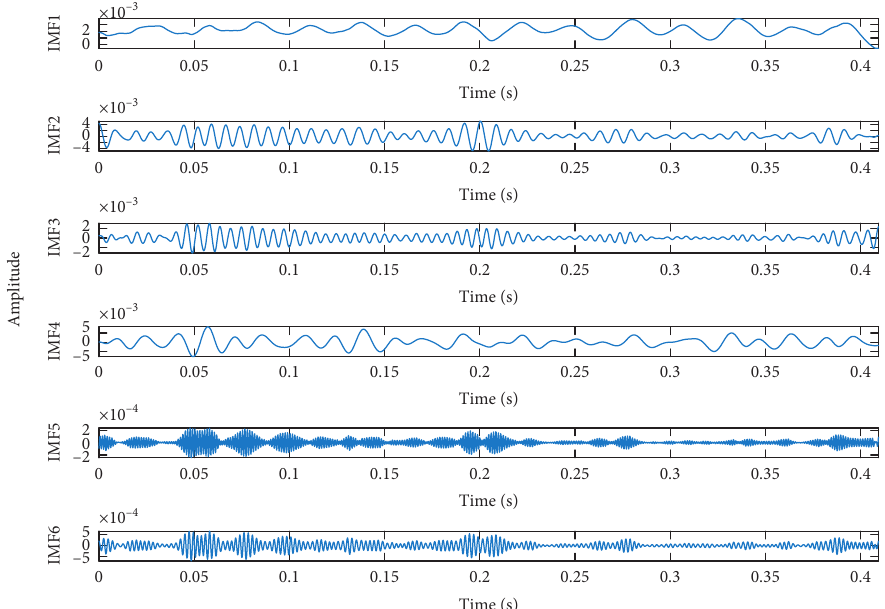
Figure 14: The time-domain diagram after rolling element fault signal